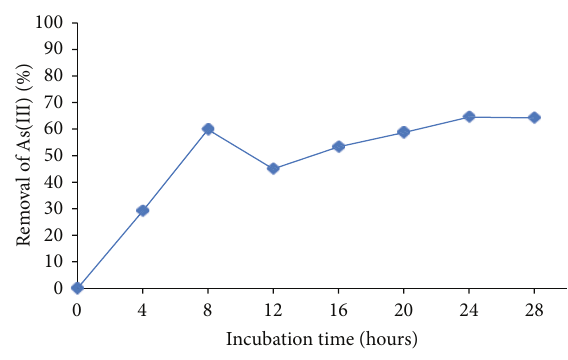
Figure 4: The effect of the concentration of As(III) in solution on the removal of As(III) ions. 100rpm, 30 ∘ C, pH 6.0, 1g of iron-coated fungal biomass of Paecilomyces